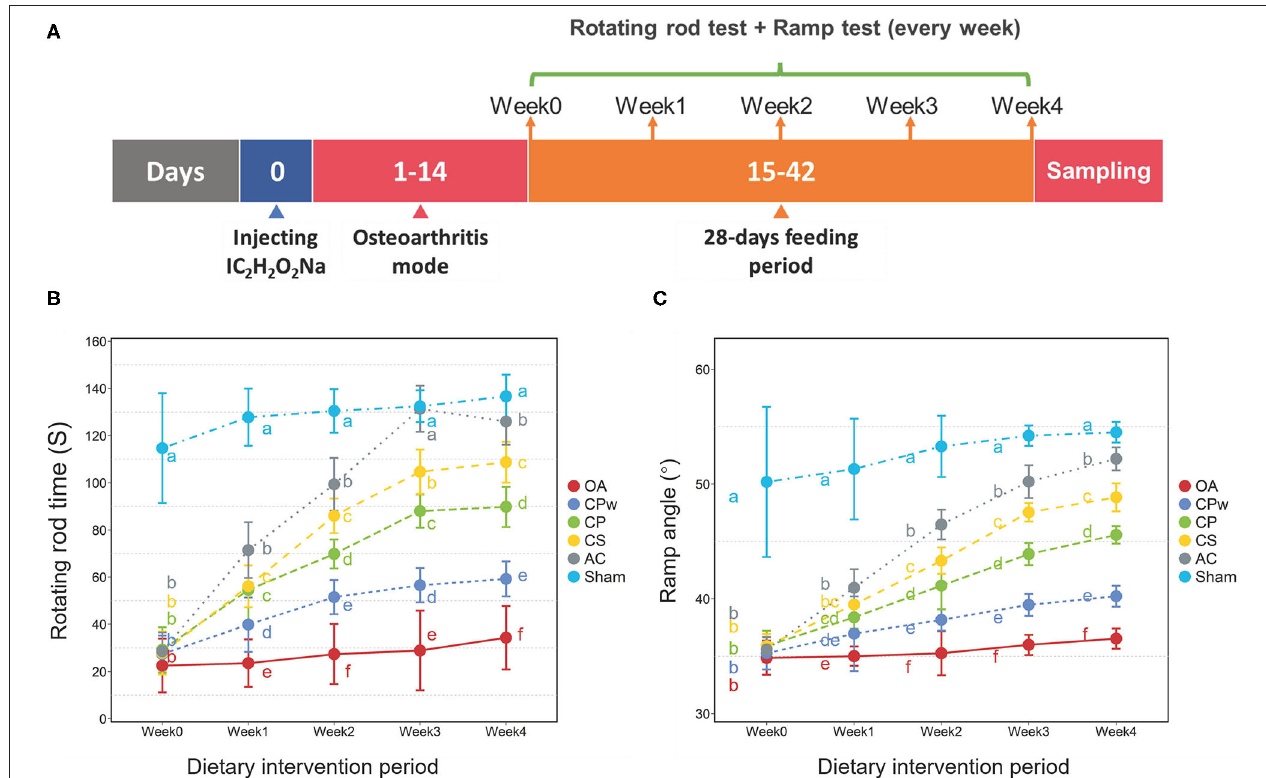
FIGURE 2 | (A) Detail time nodes of the animal experiment. (B) Rotating rod time of different groups. (C) Ramp angle of different groups. Duncan’s test was used to evaluate the significant differences between different groups. The different letters mean the significant difference between the two